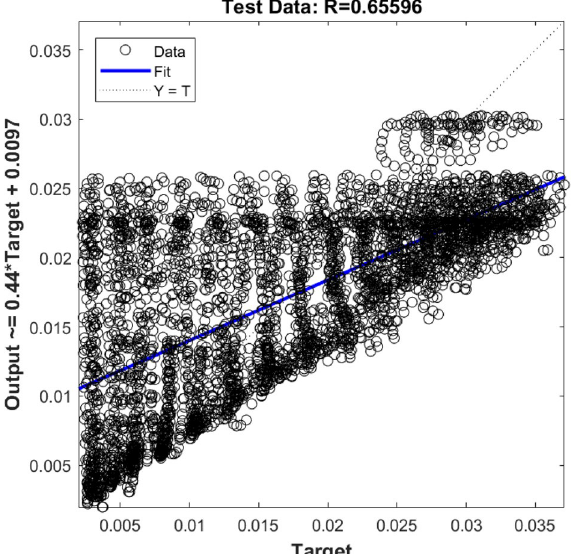
Figure 9. Testing validation of fluid velocity for ANFIS model with two inputs (x and Y computing node, the position of numerical elements). The ANFIS model’s output is the liquid velocity distribution, and it is validated against the velocity component (x-direction) in the CFD calculation (target